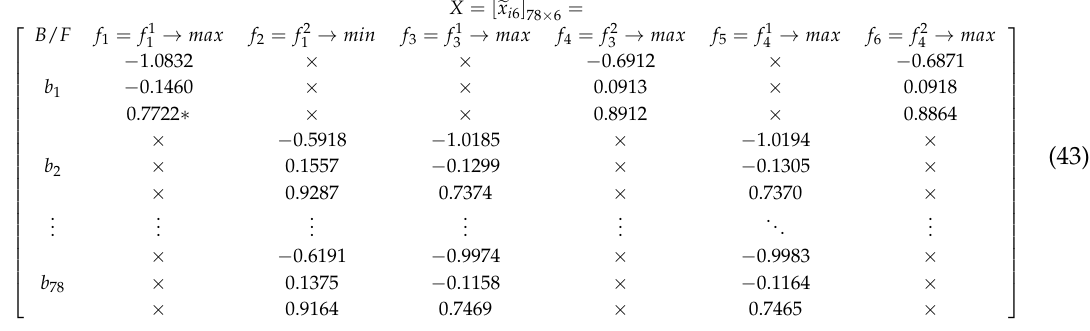
Table 7. The relative closeness of the matrix (78 × 6).